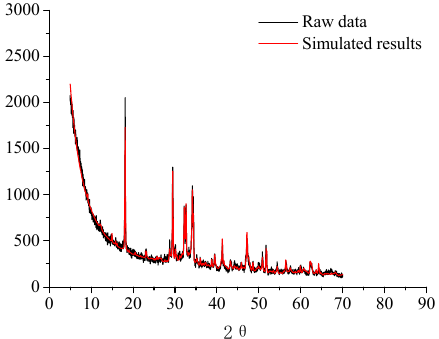
Figure 6. X-ray di ff raction quantitative analysis result of MNS-0.5% (7 days). Figure 6. X-ray diffraction quantitative analysis result of MNS-0.5% (7 days).